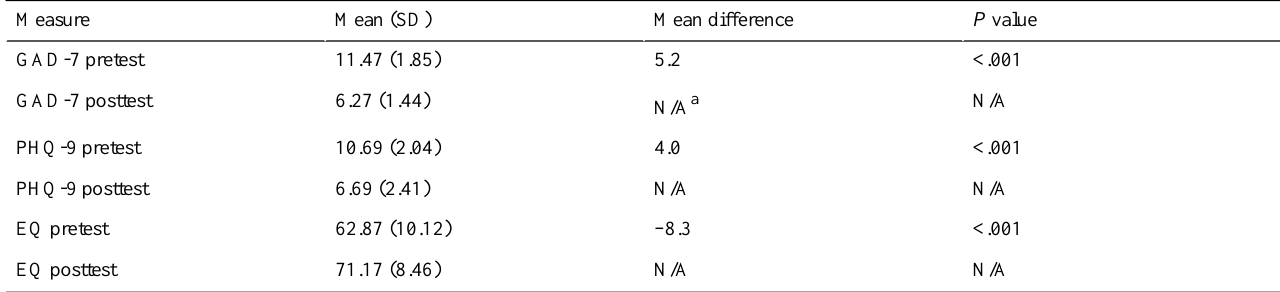
Table 2. Mean differences between the 7-item Generalized Anxiety Disorder (GAD-7) scale, the 9-item Patient Health Questionnaire (PHQ-9), and the emotional quotient